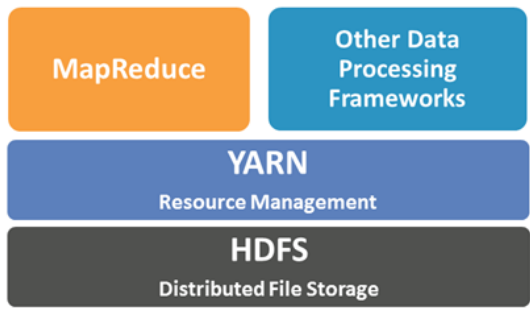
Figure 1. Hadoop V2.0